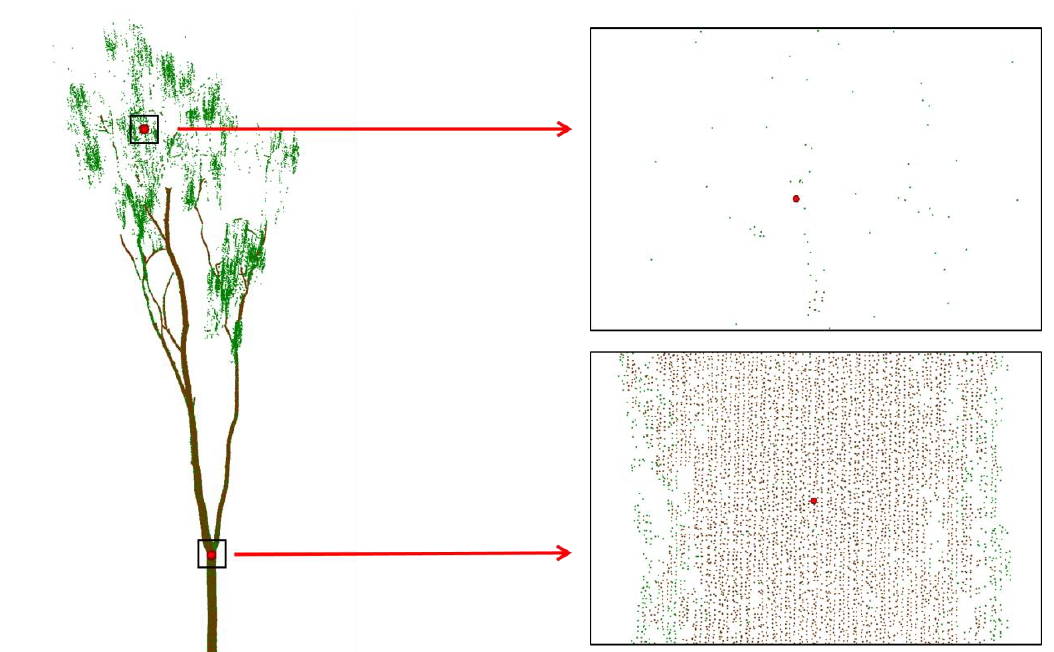
Figure 4. The spatial details of wood points and leaf points in wood points A. Brown: wood points; green: leaf points.